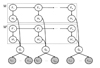
HF-HMM model for multilocus genotype inference.